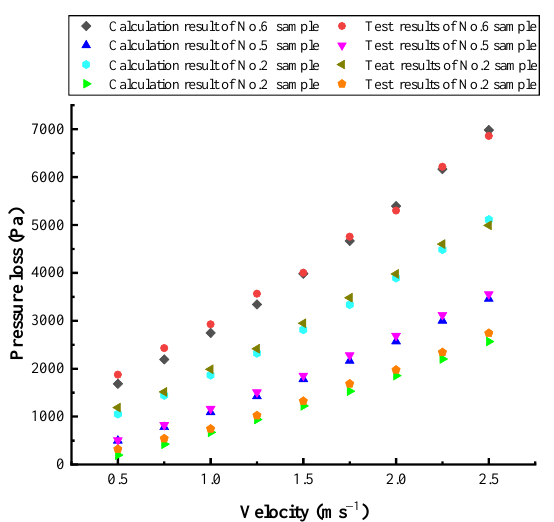
Figure 8. Test results and mathematical model calculation results of the fluid velocity variation in SLM-fabricated flow channel samples. Table 8. Comparison between the test results of the flow channel samples and the calculation results of the mathematical model.